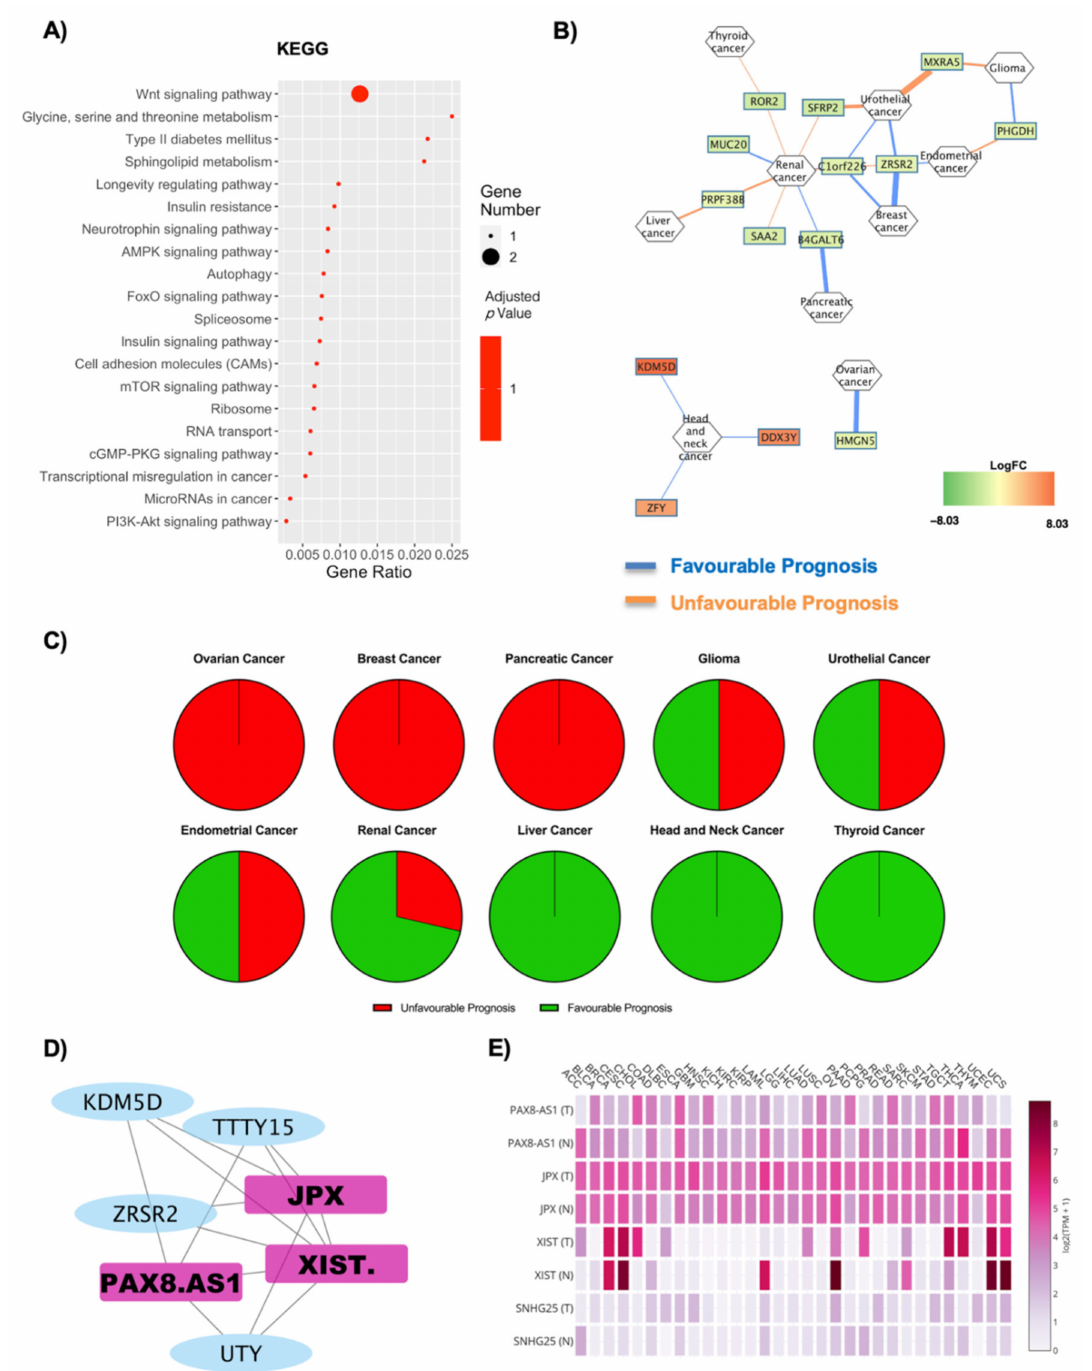
Figure 6. Cancer pathways and oncogene analysis concerning gender differences. ( A ) Dotplot of deregulated oncogenic pathways from KEGG analysis. The y-axis represents the name of the pathway, the x-axis represents the gene ratio, dot size represents the number of different genes and the color indicates the adjusted p -value. ( B ) Nodes are DE RNAs and are ranked according to fold change whereas edges indicate disease prognosis and are colored according to favorable (light blue) and unfavorable (orange) prognosis. ( C ) Pie graph displays the overall unfavorable or favorable prognosis. ( D ) Co-interaction network between lncRNAs on OBT2D vs. OBF and the oncogenes highlighted after OncoScore analysis. One main network was built, including a total of 3 lncRNAs: XIST, PAX8-AS1 and JPX. ( E ) The GEPIA2 database displays the specific annotated expression of each lncRNA in tumoral and normal